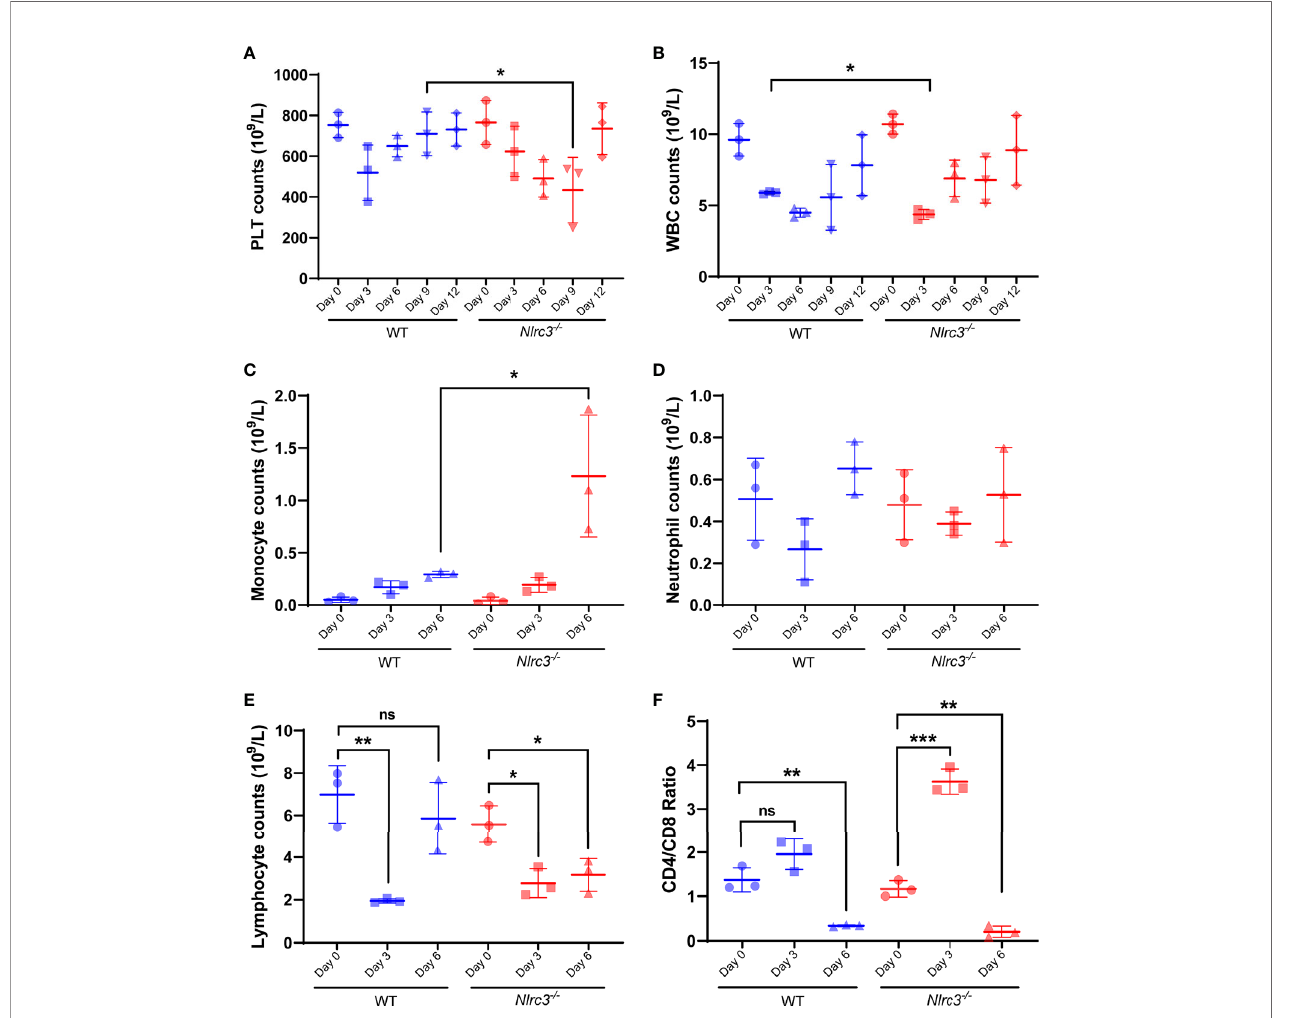
FIGURE 3 | Hematological examination of Nlrc3 − / − and WT mice post-infection. The whole blood was collected on days 3, 6, 9, and 12 post-infection for a routine blood test. The whole blood was centrifuged at 1,500 g for 10 mins at room temperature to obtain serum for biochemical tests. (A) Platelet (PLT) counts in the whole blood (10 9 /L); (B) White blood cells (WBCs) counts in the whole blood (10 9 /L); (C) Monocyte counts in the whole blood (10 9 /L); (D) Neutrophil counts in the whole blood (10 9 /L); (E) Lymphocyte counts in the whole blood (10 9 /L); (F) The ratio of CD4/CD8 in the whole blood; Bars are means ± SD. Nlrc3 − / − mice, n=3; WT mice, n=3. *p < 0.05; **p < 0.01; ***p < 0.001; ns is short for no signi fi